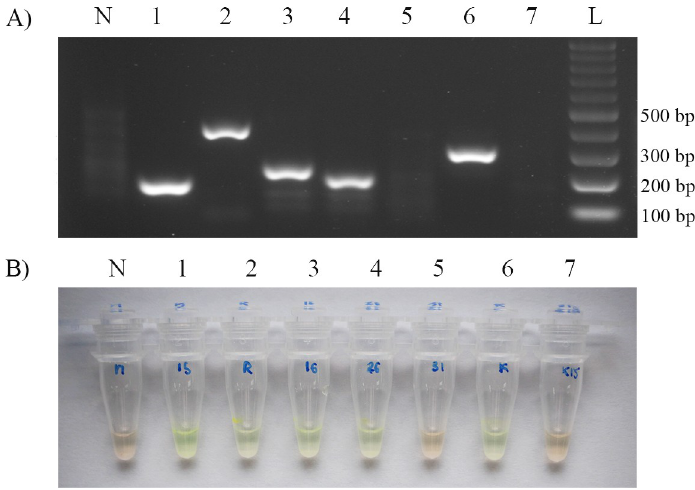
Fig 2. Results of the AS-RPA/SYBR assay when validated with M . tuberculosis strains with known mutations within the rpoB and katG genes. This figure represents the results after testing with M . tuberculosis DNA containing the rpoB 531 and katG 315 mutations. (A) RPA amplicons from different primers were detected via agarose gel electrophoresis. The product sizes from each pair of primers were 173 bp, 363 bp, 213 bp, 182 bp and 276 bp for the IS1081, rpoB , rpoB 516, rpoB 526 and katG primers, respectively. Reactions with the rpoB 531 and katG 315 primers showed no visible target band. Lane N: no-template control; Lane 1: IS1081 primer; Lane 2: rpoB primer; Lane 3: rpoB 516 primer; Lane 4: rpoB 526 primer; Lane 5: rpoB 531 primer; Lane 6: katG primer; Lane 7: katG 315 primer; Lane L: 100-bp DNA ladder. (B) The naked-eye endpoint detection method was performed by adding SYBR Green I directly to the reaction tubes. Tube N was a no-template control; tubes 5 and 7 were tested for rpoB 531 and katG 315, respectively, showing an orange colour, which implied a negative amplification result. For allele-specific primers, these results also indicated that the DNA template carried mutations at a particular site. Tubes 1–4 and 6 contained the IS1081, rpoB , rpoB 516, rpoB 526 and katG primers, respectively, showing a green colour, which implied a positive amplification result and no mutation at those allele-specific sites.